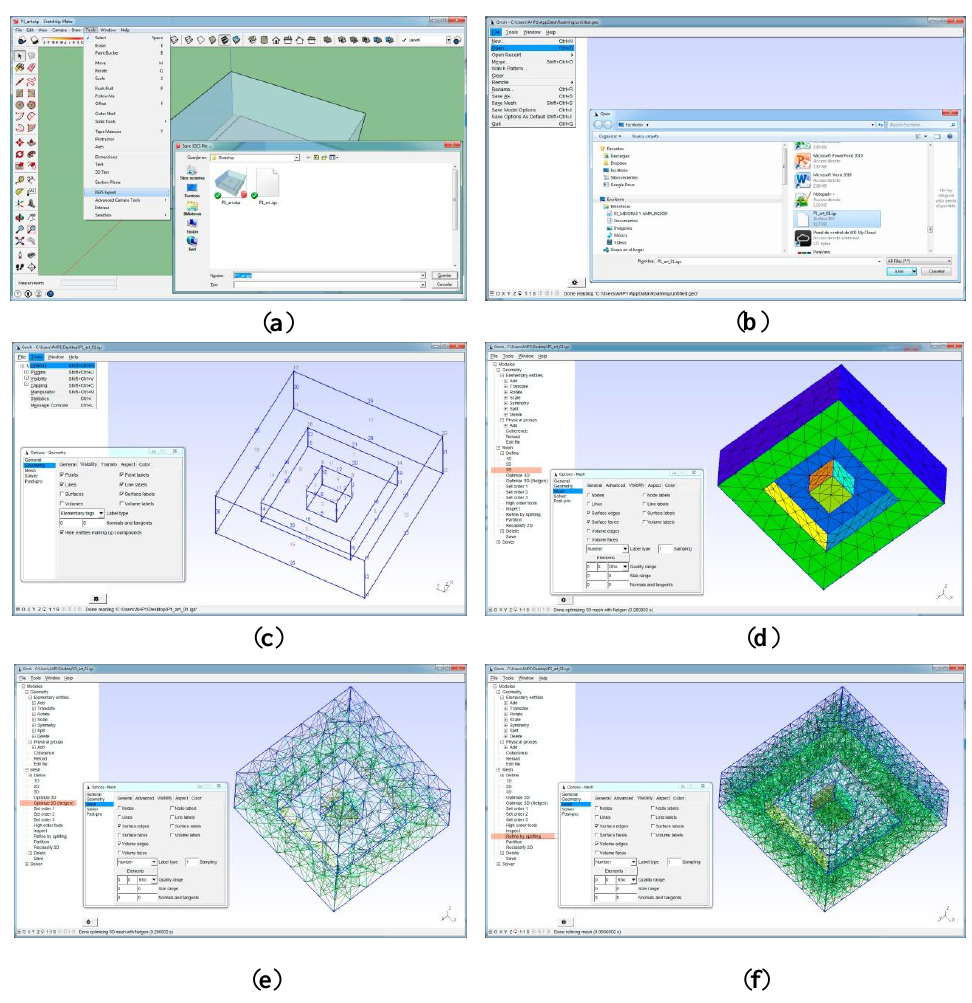
Figure 7. Exporting process of the case study geometry in the *.igs format from SketchUp, , a to f process steps. ( a ): object in SketchUp, ( b ): importing process, ( c ): object in GMESH, ( d ): initial mesh, ( e ) : mesh densification, ( f ): final mesh.